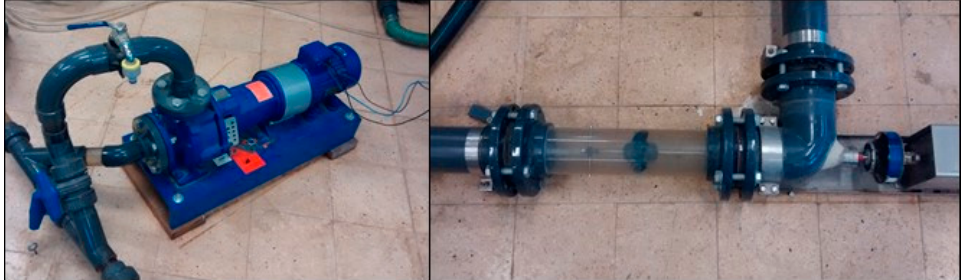
Figure 6. Hydraulic machines at IST ‐ Universidade de Lisboa: PAT ( left ); and tubular propeller ( right ).